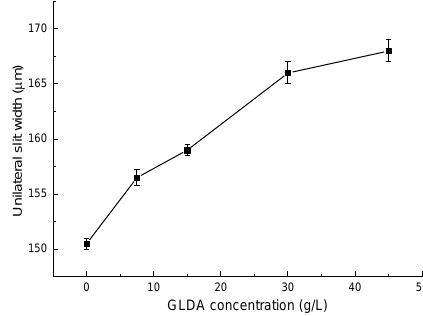
Figure 14. The variation of the unilateral slit width with GLDA concentration.